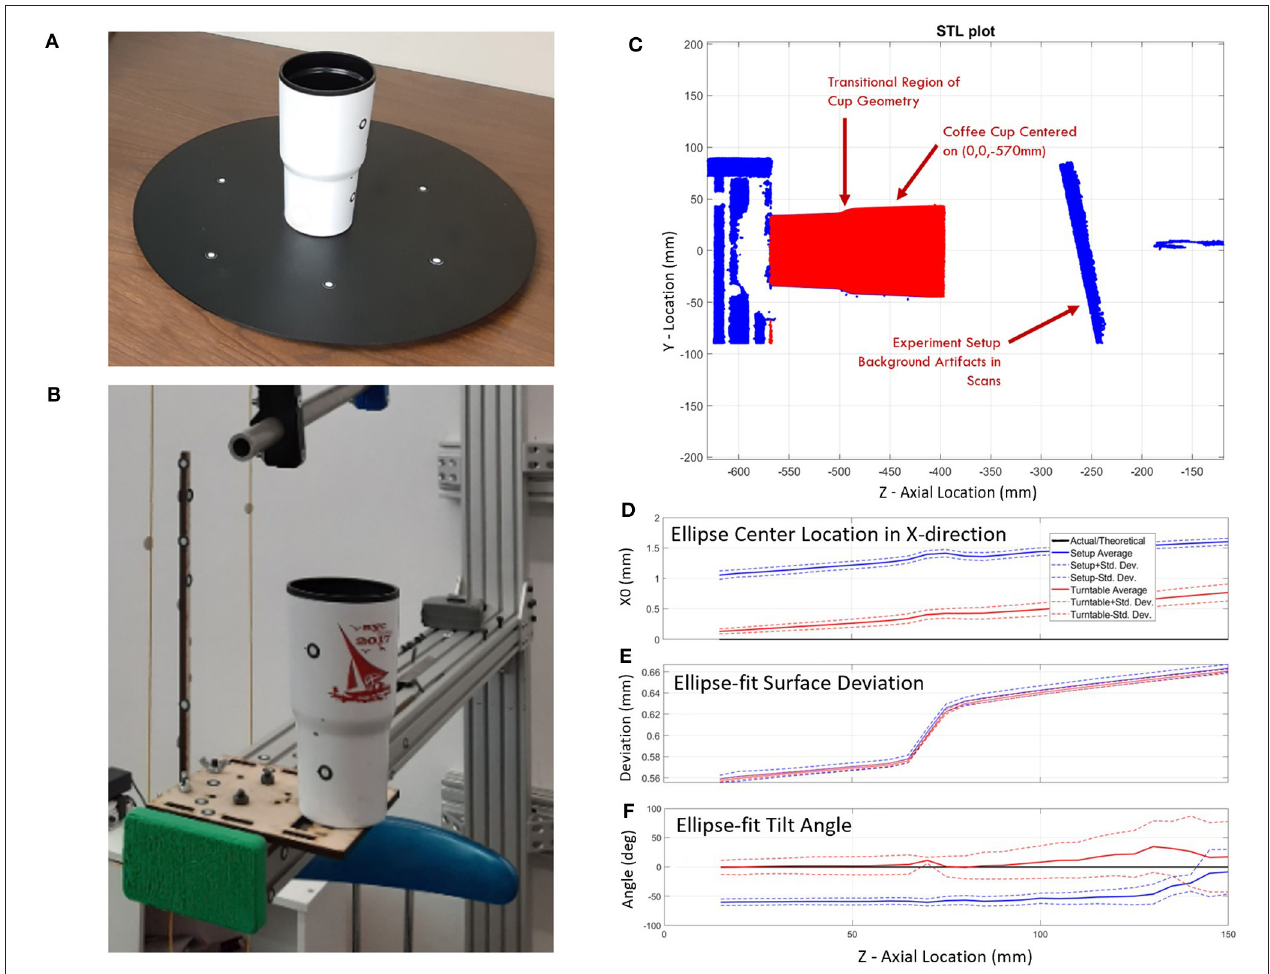
FIGURE 5 | Scanning error study using a coffee cup of known dimensions: (A) on turntable and (B) in the experimental setup. A comparison between the turntable and experimental setup scan (C) show: (D) an X-direction bias in the center location of the ellipse, (E) increased deviations from the ellipse-fit surface for larger diameters and higher cup heights, and (F) stable ellipse tilt angles on both setups over the first 100mm and increasing variability over the last 50mm.